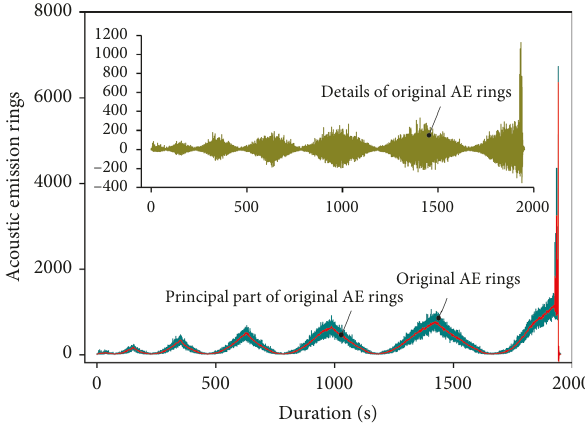
Figure 10: Time-varying AE rings during the entire rock de- formation and